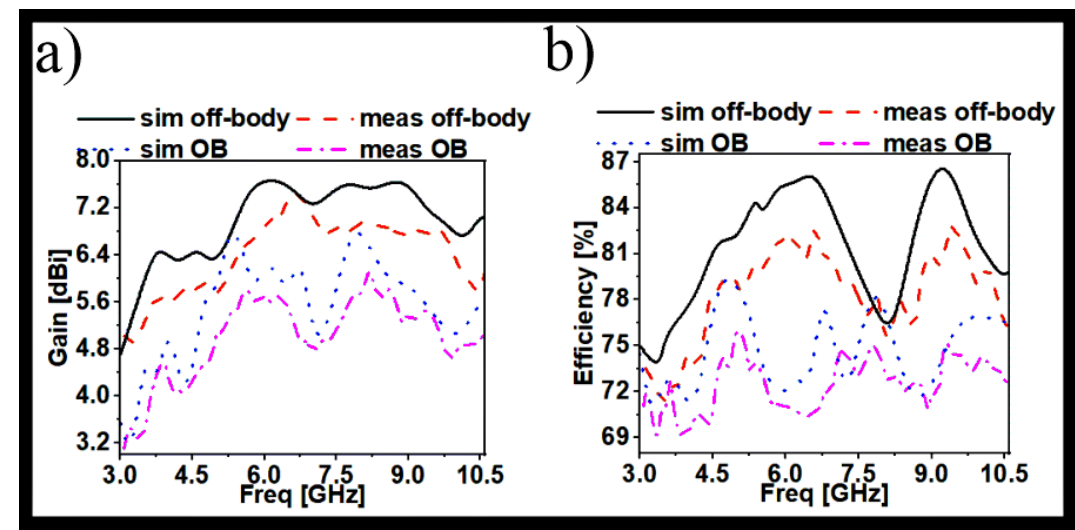
Figure 11. Simulations vs. measurements: ( a ) gain; ( b ) efficiency.